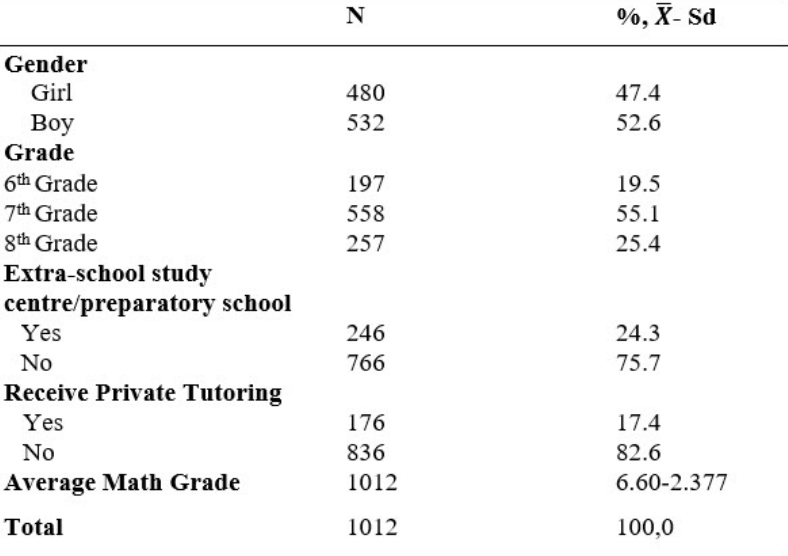
Frequency and Percentages of the Students Constituting the Sample According to Demographic